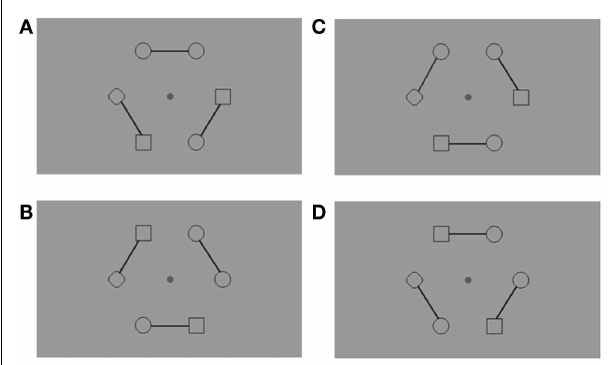
FIGURE 2 | Example of the stimuli used with an arrangement of figures around a central fixation point. Subjects had to fixate the central point throughout the trials, and this was checked with continuous eye-tracking (Cambridge Research System, 50Hz). Connecters were introduced to link elements in pairs. Consequently, the target pair could be either connected across-hemifields (A) , connected within the same hemifield (B) , unconnected across-hemifields (C) , or unconnected within the same hemifield (D) .There was always a diamond ( ) on the horizontal meridian, which remained in the same location during a block of trials, either in the right or the left hemifield. Subjects were informed about the position of the diamond before the experimental block.The diamond ensured that (1) only two adjacent figures were identical, and (2) the target pair was located in equal proportion in the across-hemifield and within-hemifield